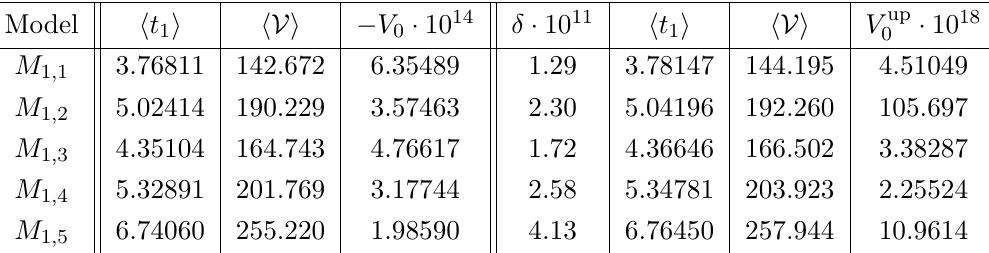
Table 6 . KKLT vacua using the scalar potentials (6.9) and (6.10) before and after the anti-brane uplifting corresponding to p = 4 , and for all the pCICY 3-folds with h 1 , 1 = h 1 , 1 parameters are set as W minimized at h ρ